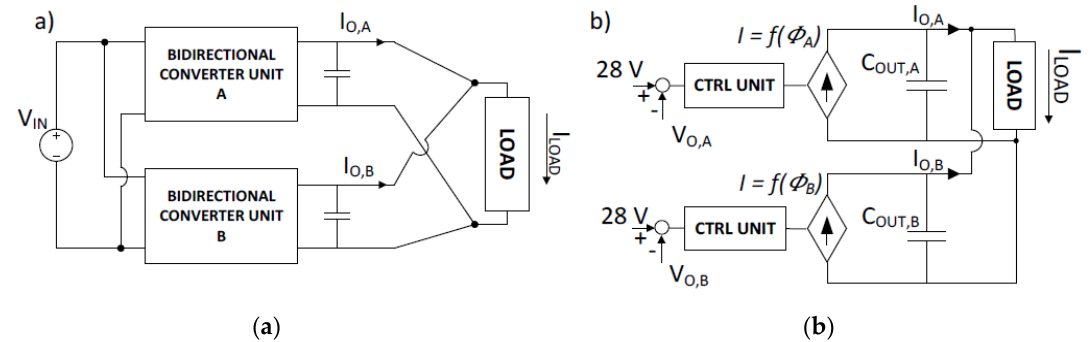
Figure 13. ( a ) Parallel connection of 2 BDCs; ( b ) controlled current source equivalent model.